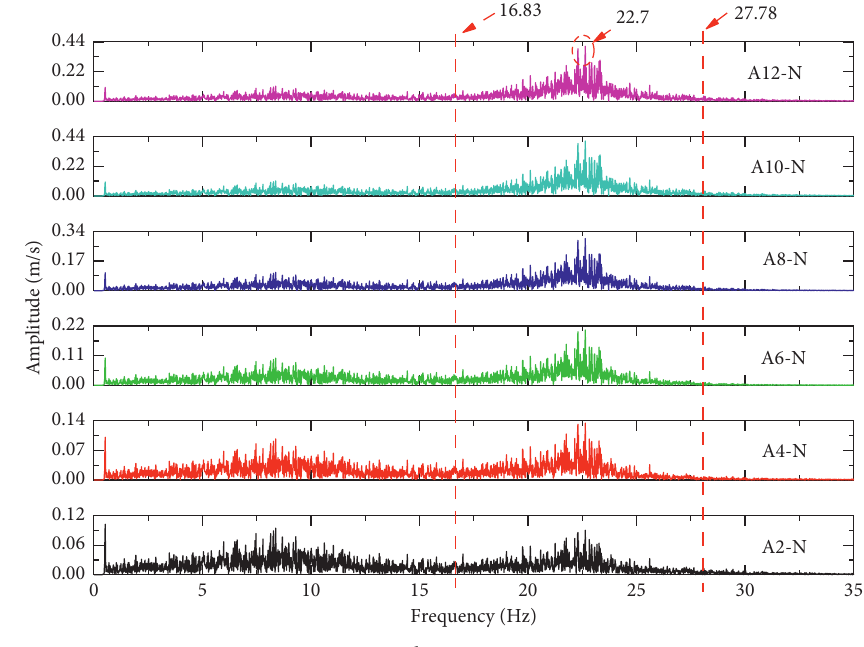
Figure 7: Free vibration Fourier spectra.